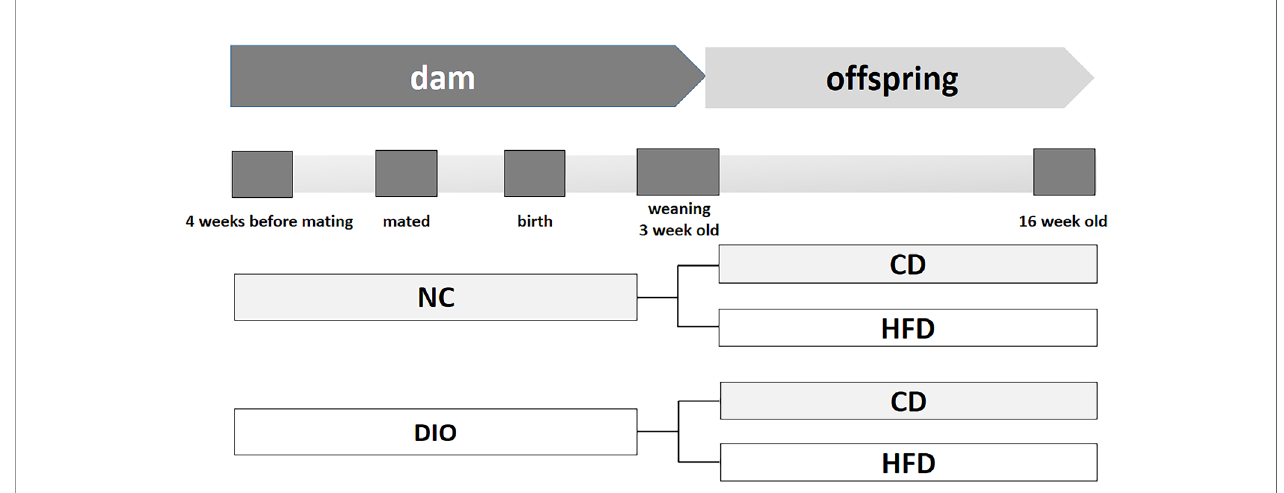
FIGURE 1 | Schema of animal experiment protocol. NC, normal control; DIO, diet induced obesity; CD, control diet; HFD, high-fat